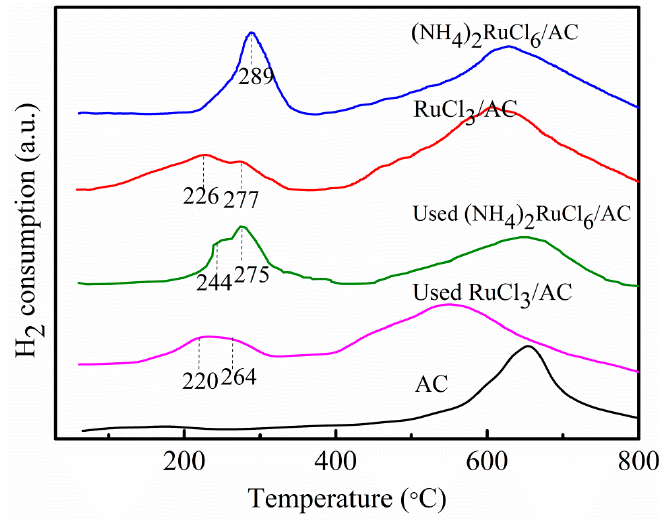
Figure 4. TPR profiles of the Ru ‐ based catalysts with 1.0 wt % Ru loading. Table 3. The relative contents and binding energies of Ru species in the fresh and used catalysts with 1.0 wt % Ru loading.